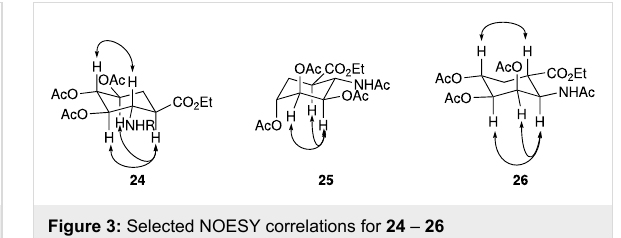
and subsequent peracylation of dienes 4 and 5 proved to be facio -specific and afforded cyclohexenyl derivatives 18 and